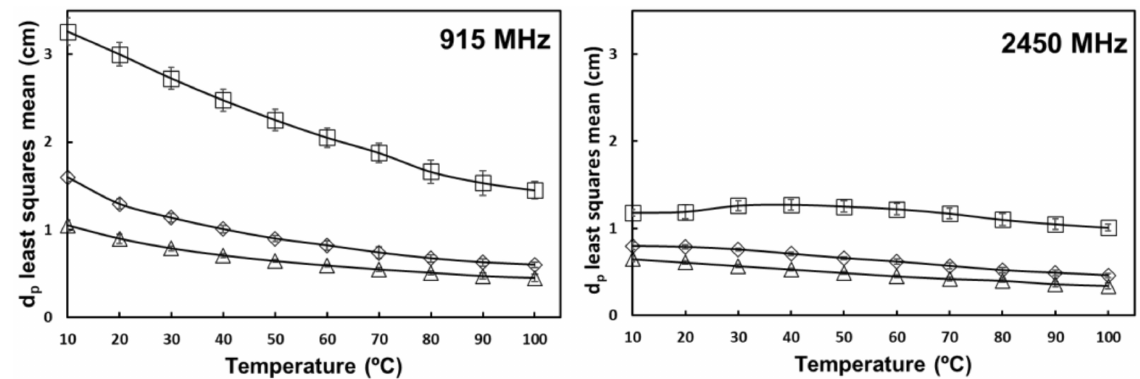
Figure 9. Temperature and salt interaction effect on the penetration depth of tomato homogenate at 915 and 2450 MHz. ( ) 0% salt ( ) 0.5% salt ( ) 1% salt. Error bars correspond to standard